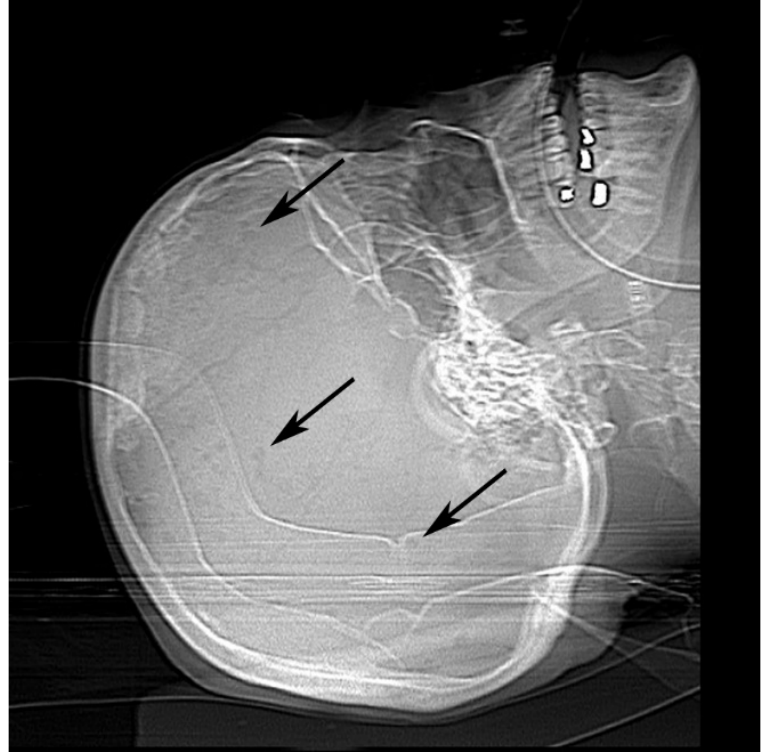
Figure 1. Antemortem X-ray of calvarium showed multiple punctate lucencies (black arrows). Shortly after completing these tests, she went into respiratory failure and was intu- bated, then admitted to the hospital. During her stay, she developed severe hypotension (84/55 mmHg), bradycardia (20–30 beats per minute), and bilateral pleural effusion. Chest compressions were performed on multiple occasions to keep her cardiac rhythm stable, while chest tubes were frequently draining fluid to manage the effusion. To assess for mul- tiple myeloma, her physicians scheduled a bone marrow biopsy. However, they ultimately canceled the biopsy after they deemed she was too unstable to undergo the procedure. By this time, she had been intubated in the hospital for several weeks, and was beginning to show signs of multi-organ failure in the liver (macrocytic anemia and thrombocytopenia with increased ammonia, liver enzymes, prothrombin time, and partial